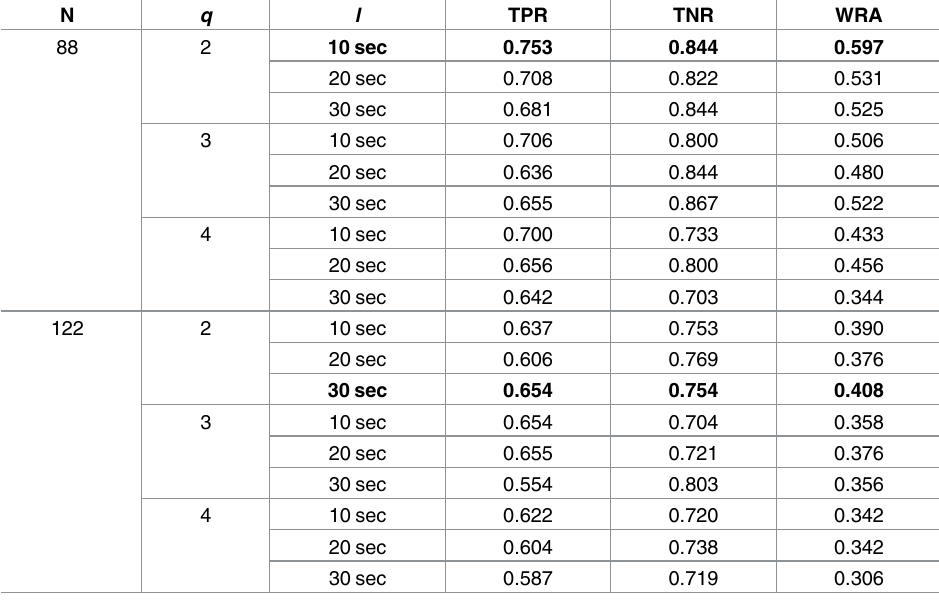
Table 3. Performance of